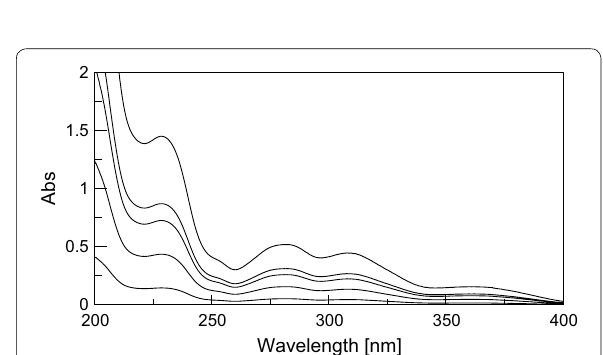
Fig. 4 Zero order absorption spectra of DRO in mixtures (2, 6, 10, 12, and 20